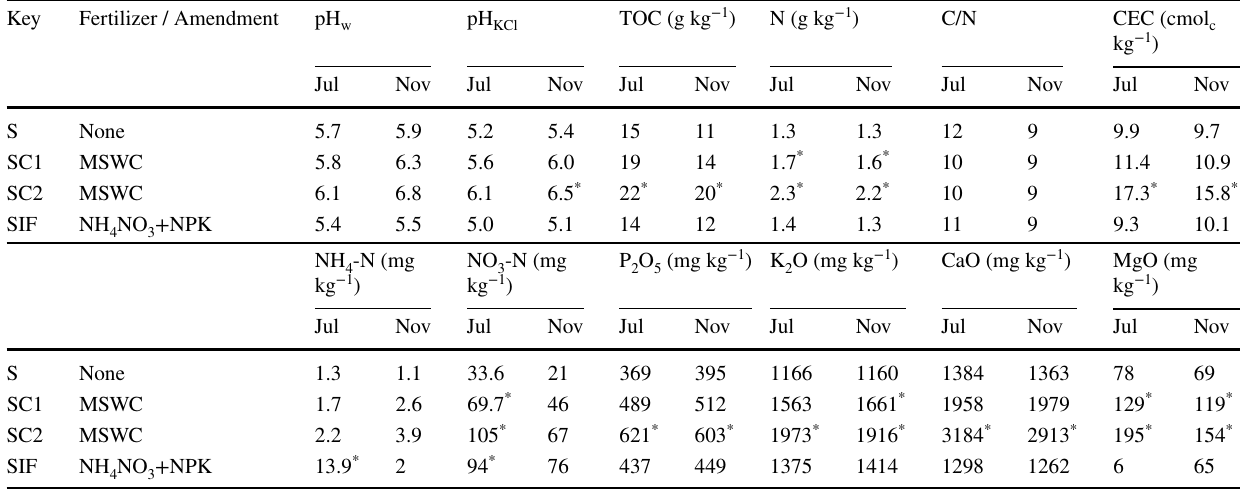
Statistically significant differences ( P < 0.05) with respect to the control are indicated by an asterisk – Not determined on the SIF Table 4 Chemical properties of the soils during the experiment